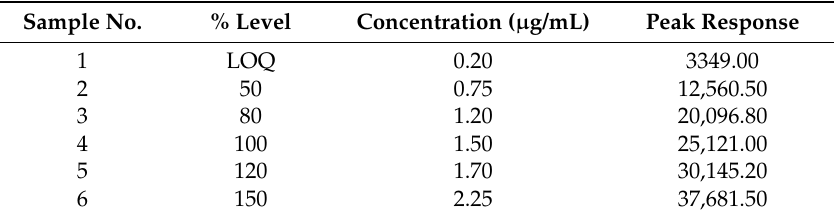
Table 4. Linearity data for the S -enantiomer (RAS-III).